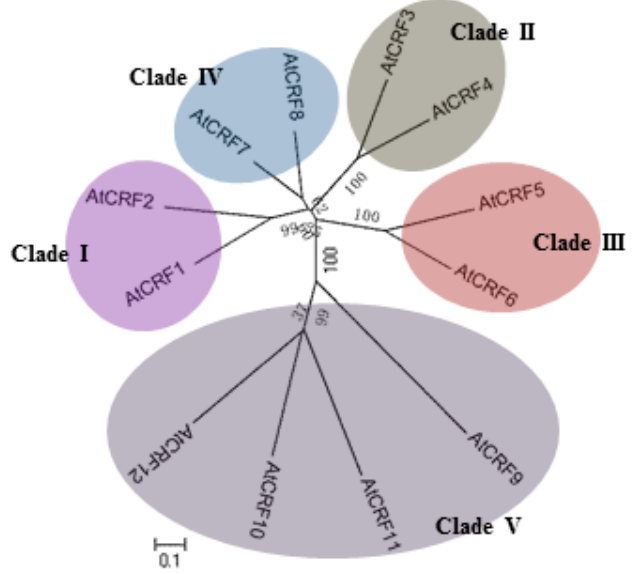
Figure 6. Phylogenetic relationship of CRFs in Arabidopsis .